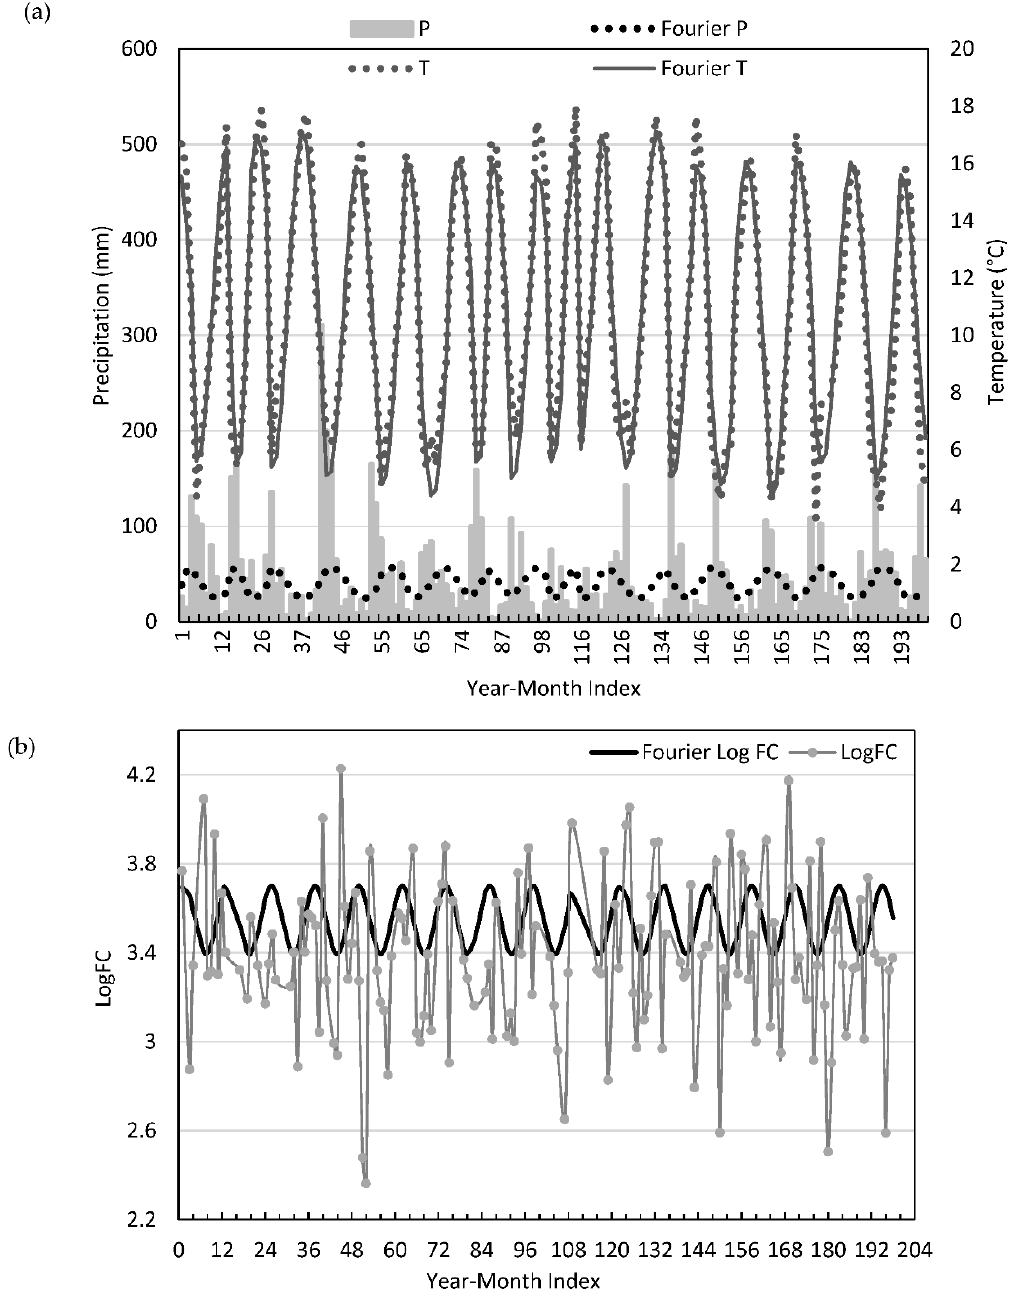
Figure 5. ( a ) Monthly climate variables and best fit Fourier series; and ( b ) Log FC y,m data with fitted Fourier series model.